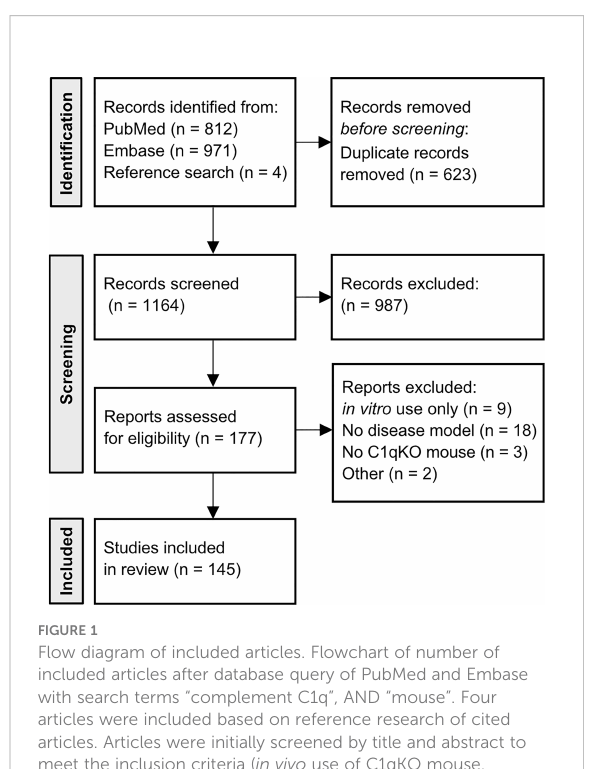
FIGURE 1 Flow diagram of included articles. Flowchart of number of included articles after database query of PubMed and Embase with search terms “ complement C1q ” , AND “ mouse ” . Four articles were included based on reference research of cited articles. Articles were initially screened by title and abstract to meet the inclusion criteria ( in vivo use of C1qKO mouse, investigated disease model). 177 articles underwent full text review. Thirty-two publications did not ful fi ll the